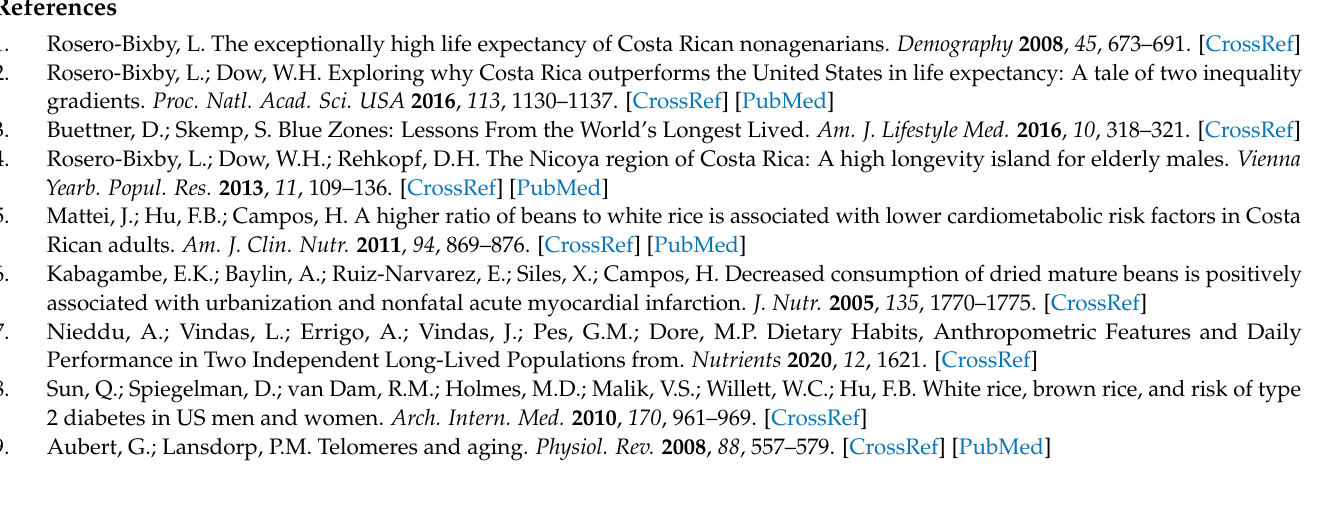
diet. Figure S1: Telomere length (bp) wave 2 vs. telomere length wave 1